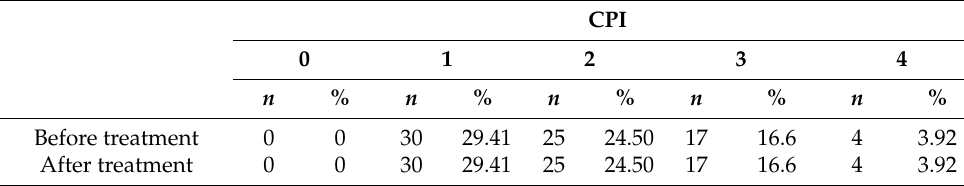
Table 5. Chemotherapy cycle versus CPI.